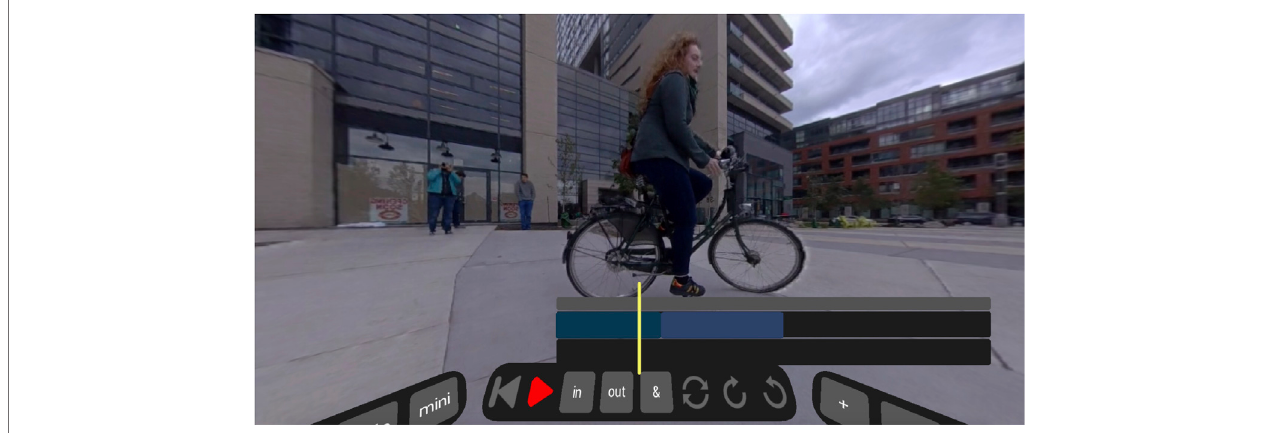
FIGURE 1 | The immersive video editor is used to render a 6DoF video in VR. The editor contains UI elements for editing and replaying the video. Using video material publicly available (http://pseudoscience.pictures) processed with Stereo2Depth (Gladstone and Samartzidis, 2019).